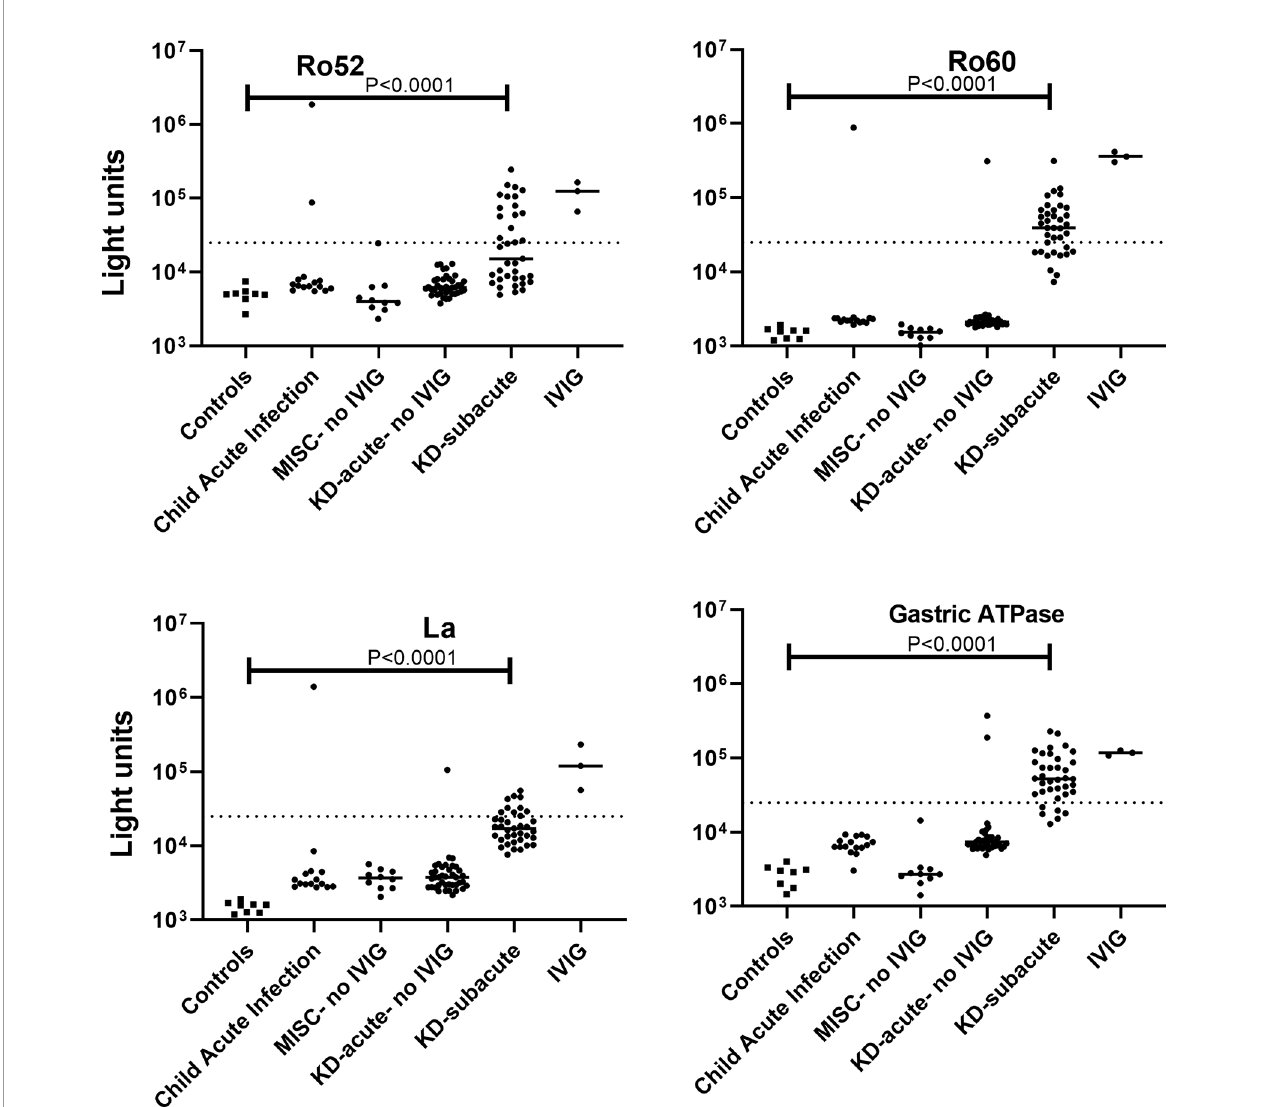
FIGURE 3 | Autoantibodies in the serum/plasma of patients with MIS-C and Kawasaki disease (KD) are due to administration of IVIG. Autoantibody levels are plotted in light units on a log 10 scale. The dashed lines represent the cut-off level for determining positive antibody titers as described in the Methods. Results from 8 sera from children not infected with SARS-CoV-2 (Controls), 15 sera from children with acute febrile infection not due to COVID-19 or KD (child acute infection), 10 sera from patients with MIS-C who did not receive IVIG (MISC-no IVIG), 39 sera from children with acute KD (KD-acute), 37 sera children with subacute KD (KD- subacute), and three preparations of IVIG are shown. Only statistically signi fi cant P values from the Fisher exact test examining autoantibody prevalence differences between the control group and the groups of children are